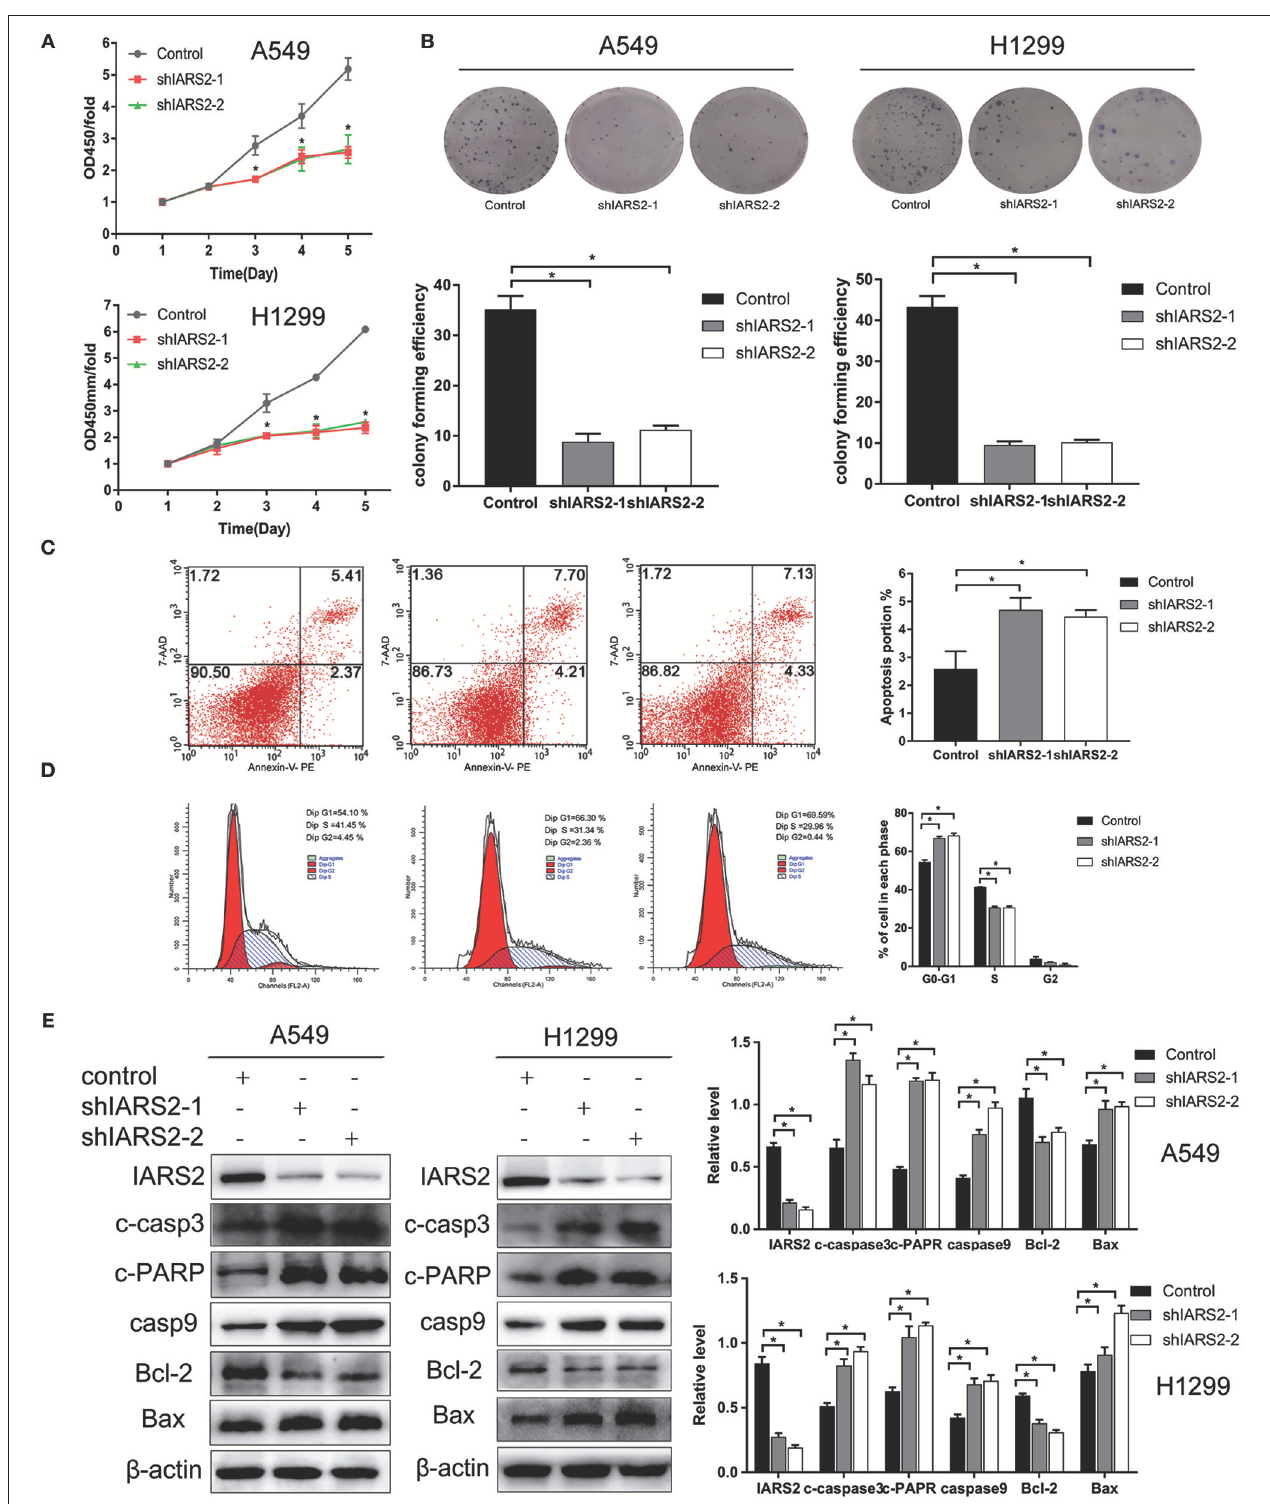
FIGURE 2 | Effects of IARS2 knockdown on cell proliferation, cell cycle progression and apoptosis in NSCLC cells. (A) Cell Counting Kit-8 assay was used to evaluate A549 and H1299 cell growth after IARS2 knockdown. (B) Colony formation assay was used to evaluate A549 and H1299 cell growth after IARS2 knockdown. (C) Apoptosis was evaluated using flow cytometry in IARS2 knockdown and control A549 cells. Representative flow-cytograms are shown, and apoptotic rates were